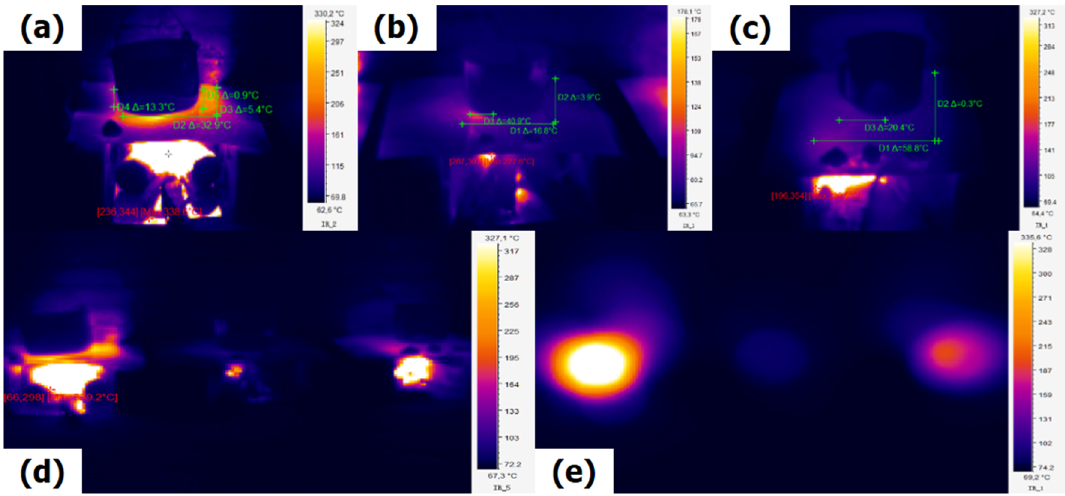
Figure 10. Combustion at 20 min: ( a ) briquette; ( b ) pine firewood; ( c ) oak firewood. ( d ) Integrated image of the three fuels; ( e ) emissions in the form of radiant bodies from the three fuels.